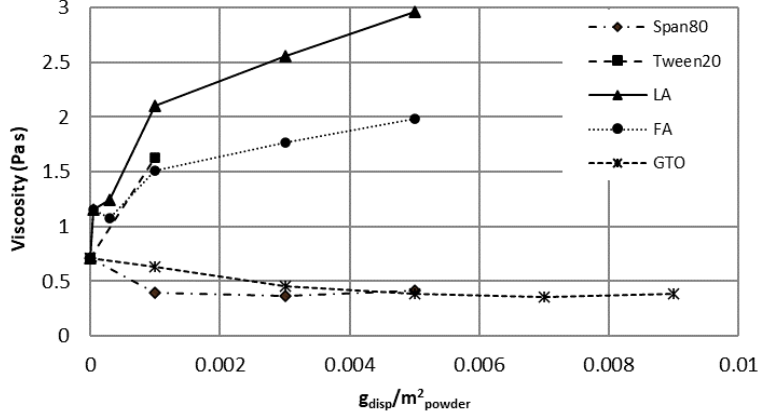
Figure 2. Viscosity of the CuO-terpineol suspensions produced using different types and concentrations of deflocculants.